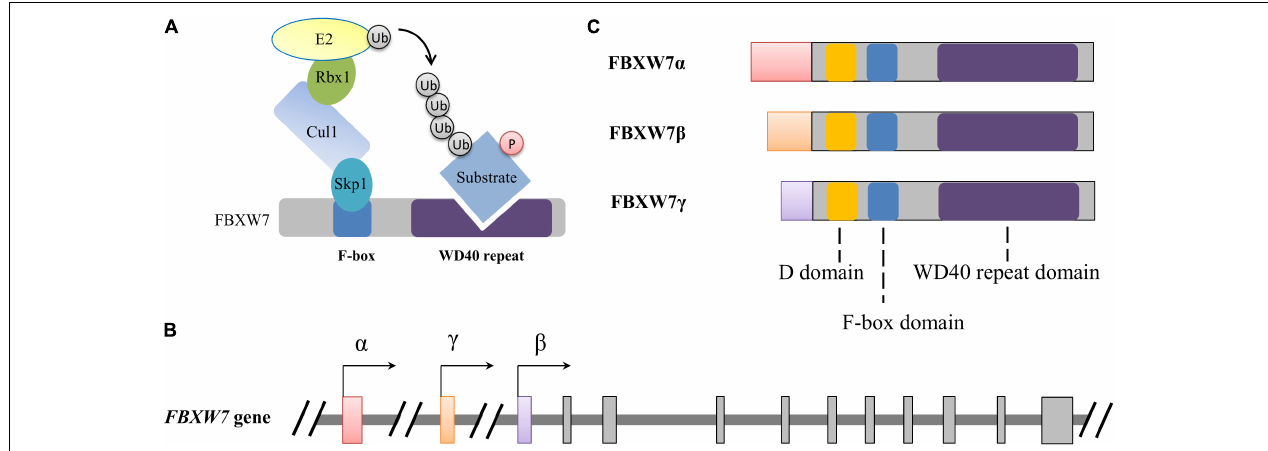
FIGURE 1 | Schematic illustration of the SCF FBXW7 E3 ubiquitin ligase complex (A) and FBXW7 gene (B) and proteins (C) . (A) Functional model of FBXW7 involved in SCF complex-mediated substrate ubiquitylation. Ubiquitin and phosphorylation is indicated with Ub and P with a circle, respectively. (B,C) Alternative transcriptional initiations from different promoters generate three distinct FBXW7 transcripts and corresponding proteins with conserved D, F-box and WD40 repeat domains. All three FBXW7 transcripts (or isoforms) share 10 common exons which were shown with gray